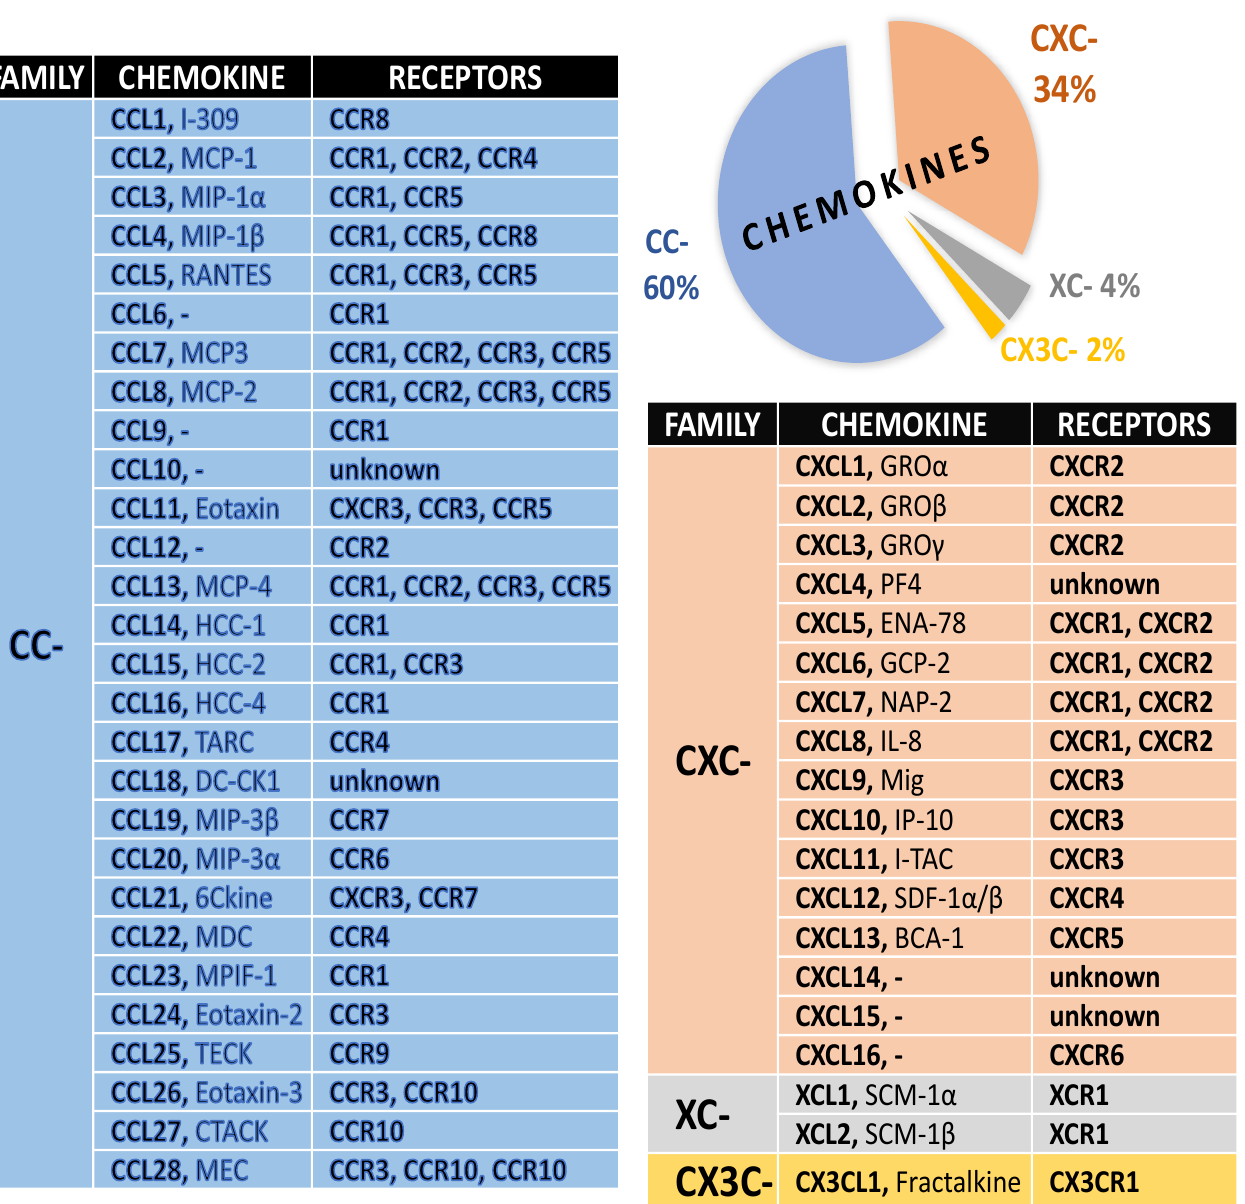
Figure 1. Classification of chemokine family—chemokines (systematic and original names) and their receptors. Abbreviations of original names of chemokines: BCA-1, B-cell-attracting chemokine 1; CTACK, cutaneous T-cell-attracting chemokine; DC-CK1, dendritic-cell-derived CC chemokine 1; ENA-78, epithelial-cell-derived neutrophil attractant 78; GCP, granulocyte chemotactic protein; GRO, growth-related oncogene; HCC, haemofiltrate CC chemokine; IL, interleukin; IP-10, inter- feron-inducible protein 10; I-TAC, interferon-inducible T-cell alpha chemoattractant; LEC, liver-ex- pressed chemokine; LCC-1, liver-specific CC chemokine-1; MCP, monocyte chemoattractant pro- tein; MDC, macrophage-derived chemokine; MEC, mammary-enriched chemokine; Mig, monokine